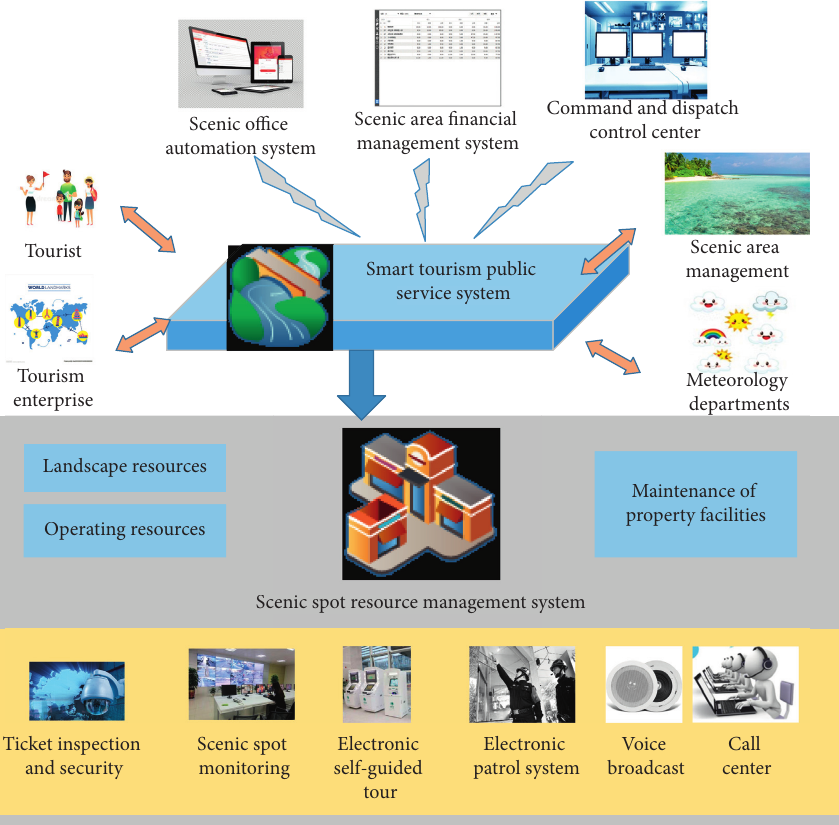
Figure 2: Overall framework of the public service system for smart tourism.